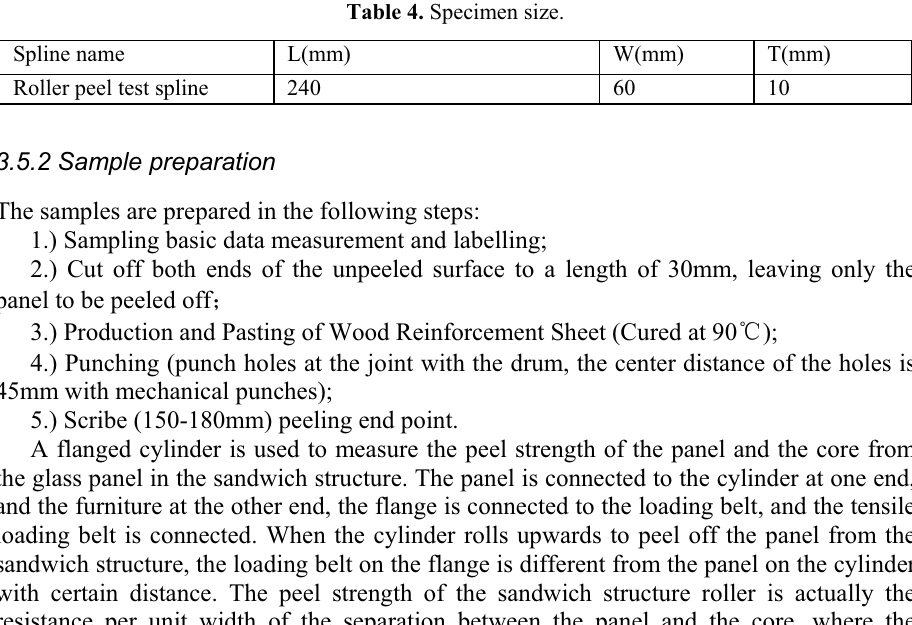
Fig. 7. Roller peeled sample.